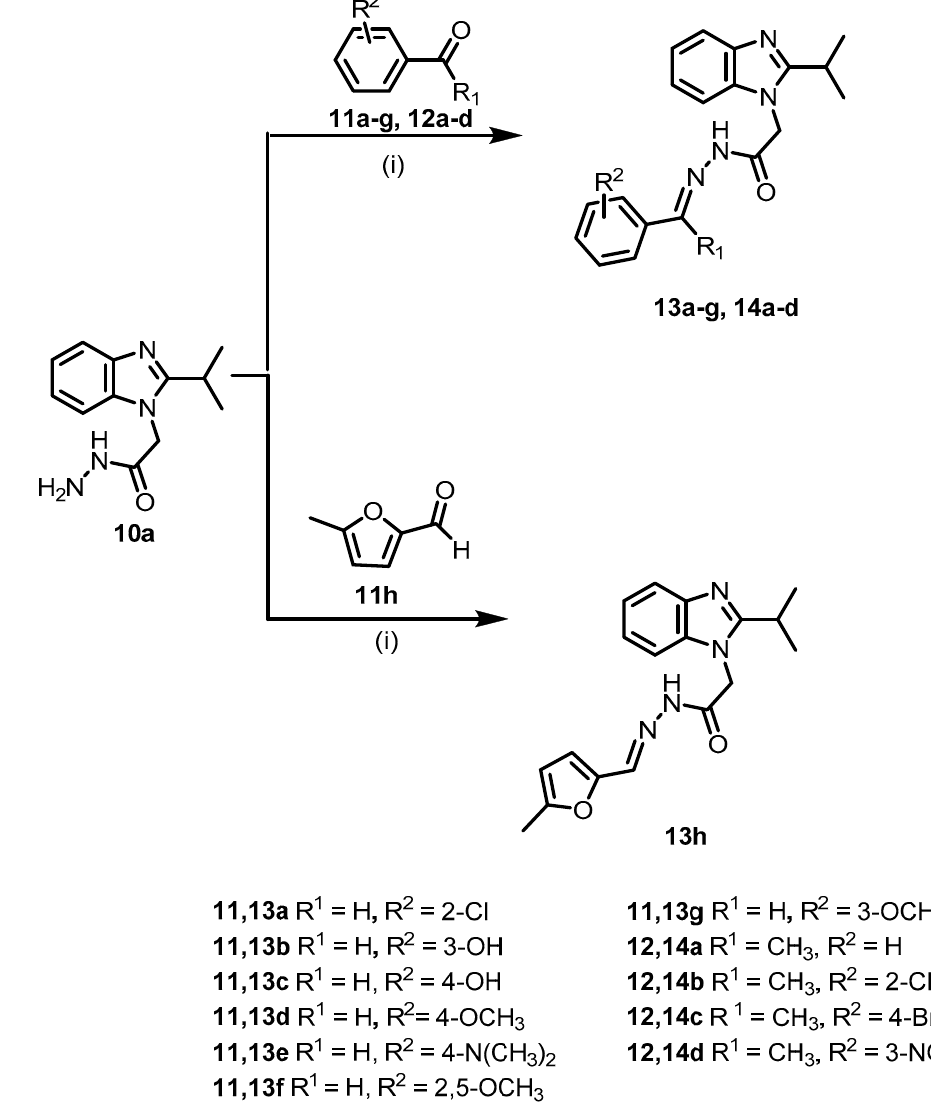
Scheme II. Synthesis of the target Schiff bases 13a – h and 14a – d .